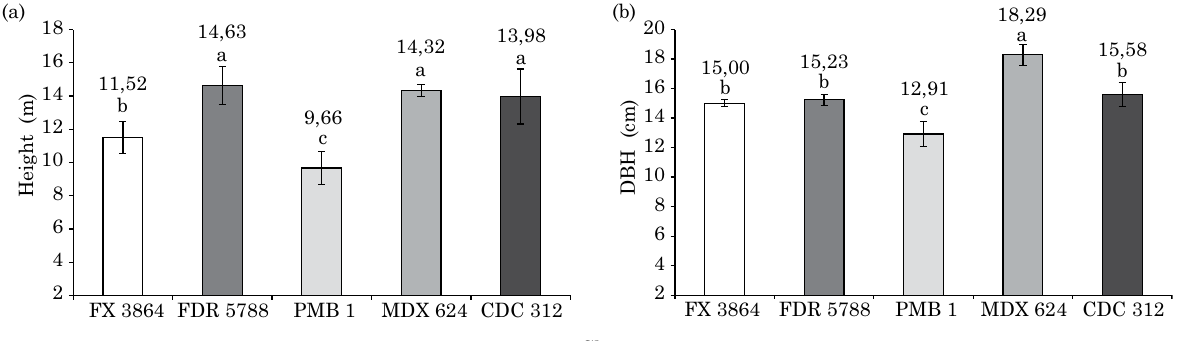
Figure 1. Total height of rubber tree clones (a) and diameter at breast height (DBH) (b). Different letters indicate that means differ by the Tukey test (p<0.05). The bars associated with each mean indicate its standard error.